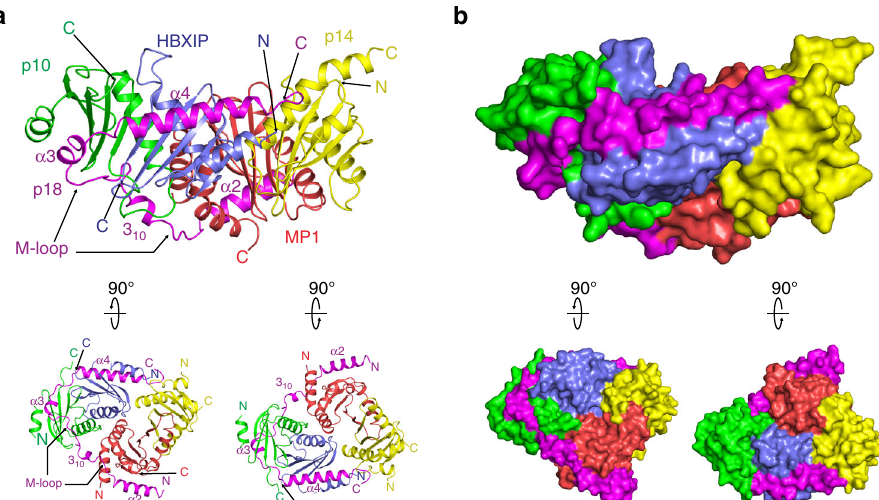
Fig. 1 The overall structure of Ragulator. a Ribbon model representation of the crystal structure of Ragulator. p18, magenta; p14, yellow; MP1, red; p10, green; HBXIP, blue; N, amino terminus; C, carboxyl terminus. The locations of helices α 2, 3 10 , α 3 and α 4, and the M-loop of p18 are shown (upper panel). The structure is viewed from two different angles rotated at 90° along the horizontal axis (lower panel). b Surface representation of Ragulator (upper panel). The structure is viewed from two different angles rotated at 90° along the horizontal axis (lower